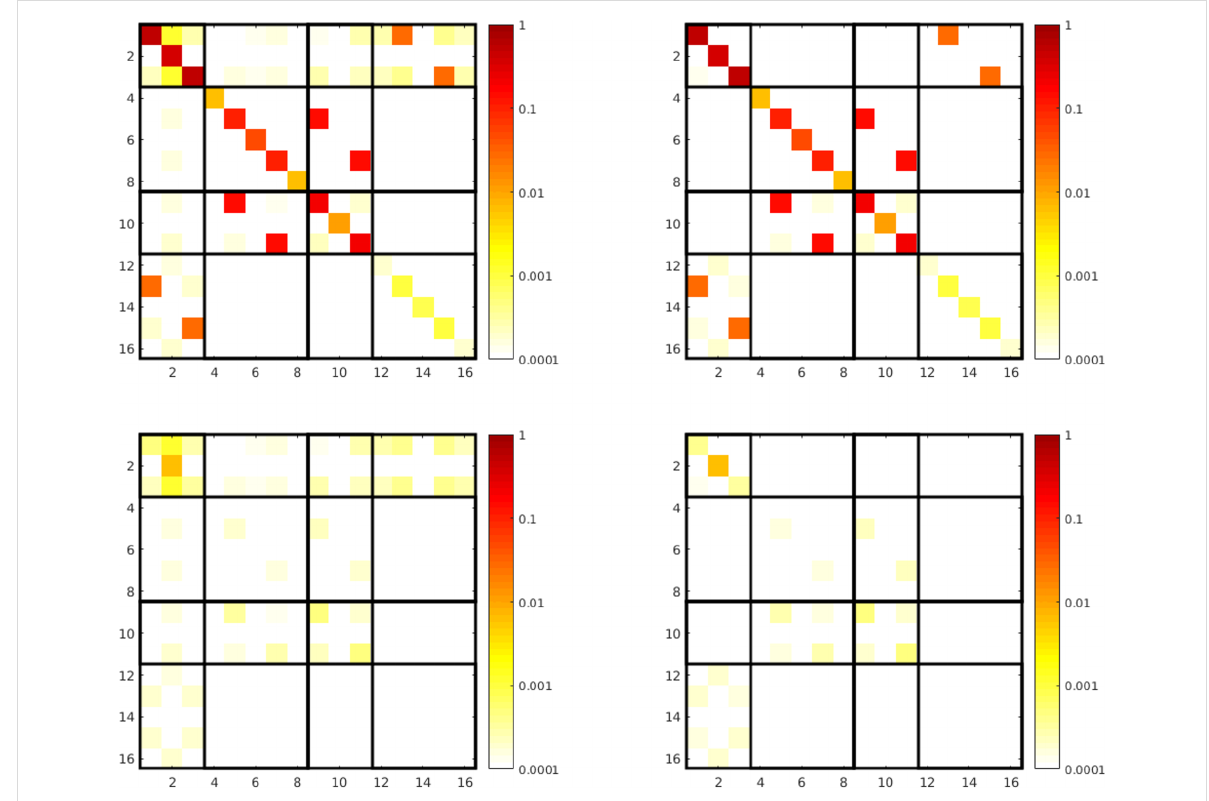
Figure 6: T-matrix entries of the dimer, calculated with the presented method at 600 THz. For the sake of clarity we show only the parts connected to the lowest two multipole contributions. On the left hand side we see the matrix with the minimum number of plane wave illuminations 48, on the right hand side with 50 extra illuminations. The bottom row shows the absolute difference to the semi-analytic solution .